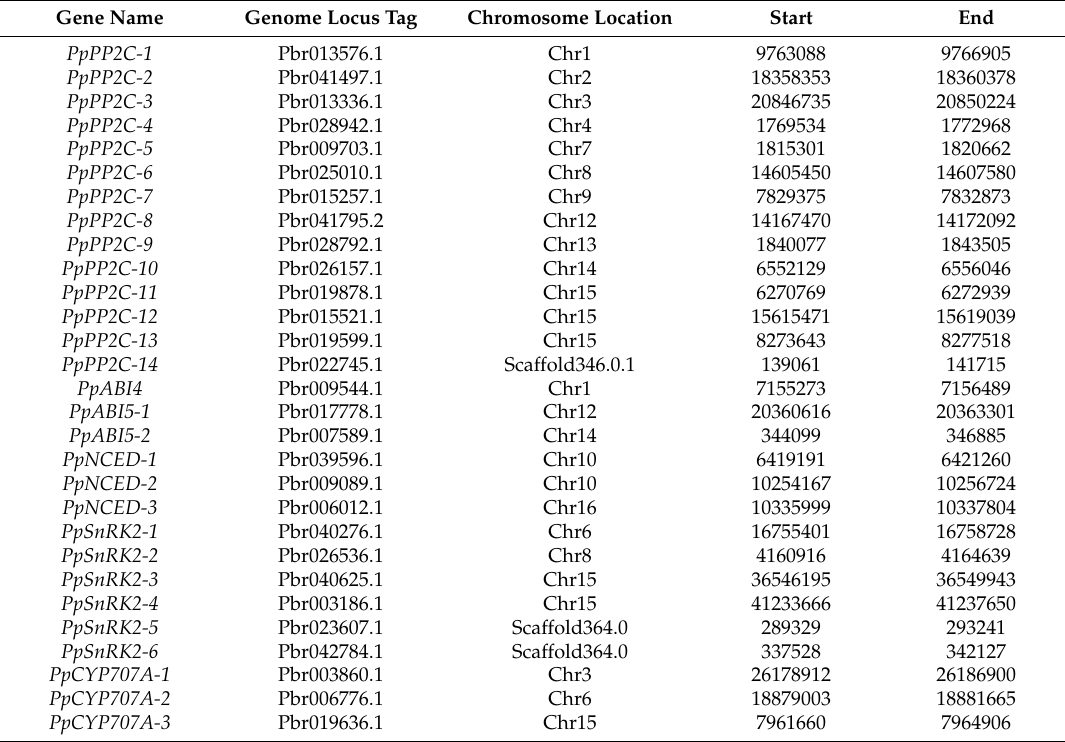
Table 1. Abscisic acid (ABA) biosynthesis, metabolism, and signaling genes located in the pear genome.